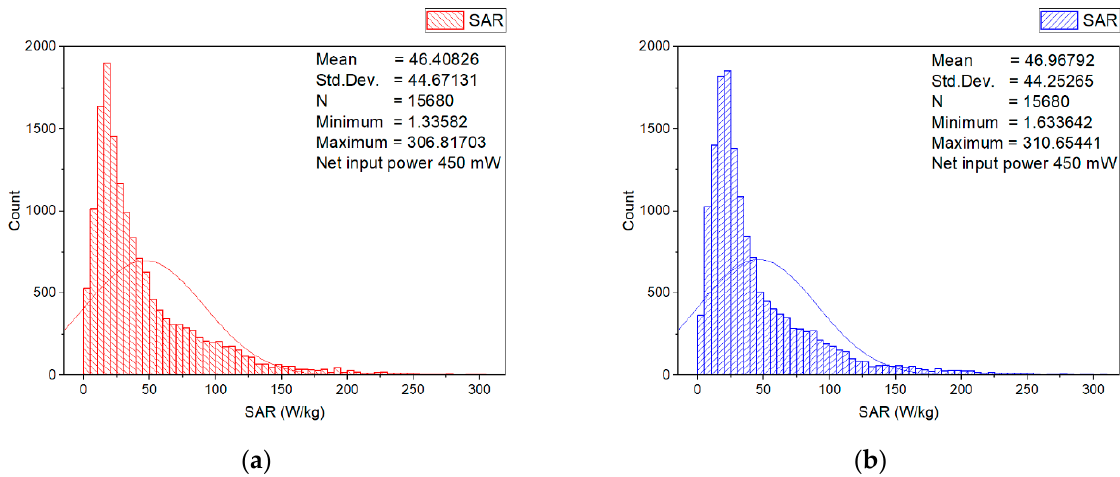
Figure 5. Histograms and descriptive statistics of SAR distribution for the erythrocyte suspensions at net input power of 450 mW in: ( a ) left and ( b ) right cuvette.